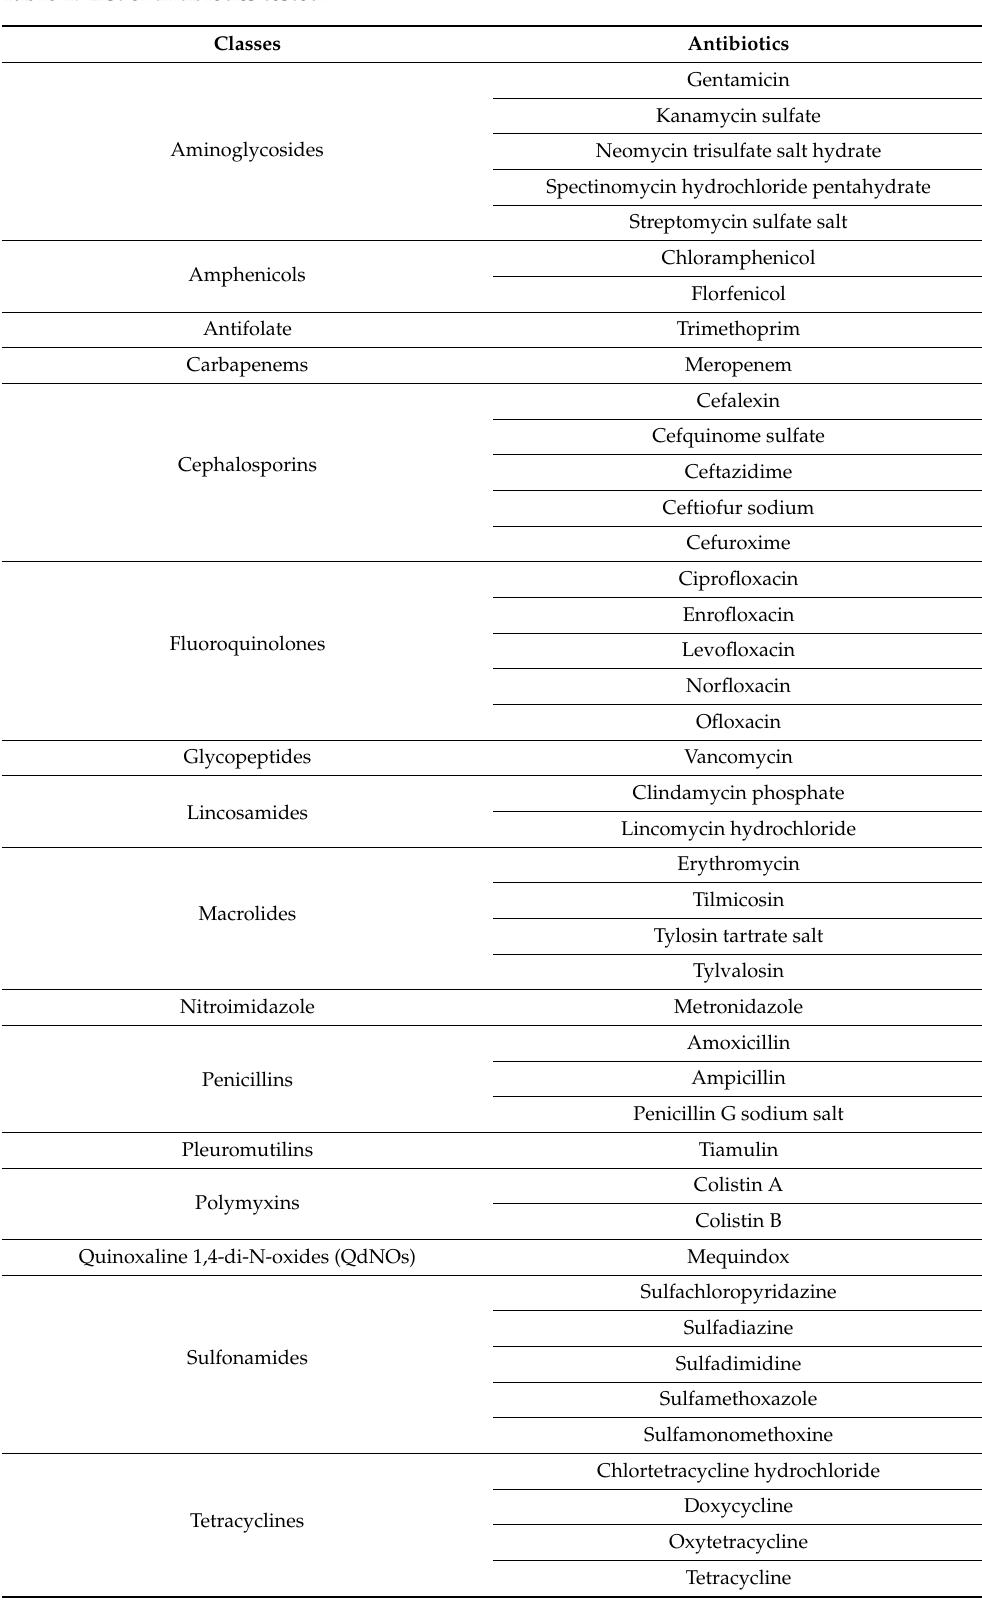
Table 1. List of antibiotics